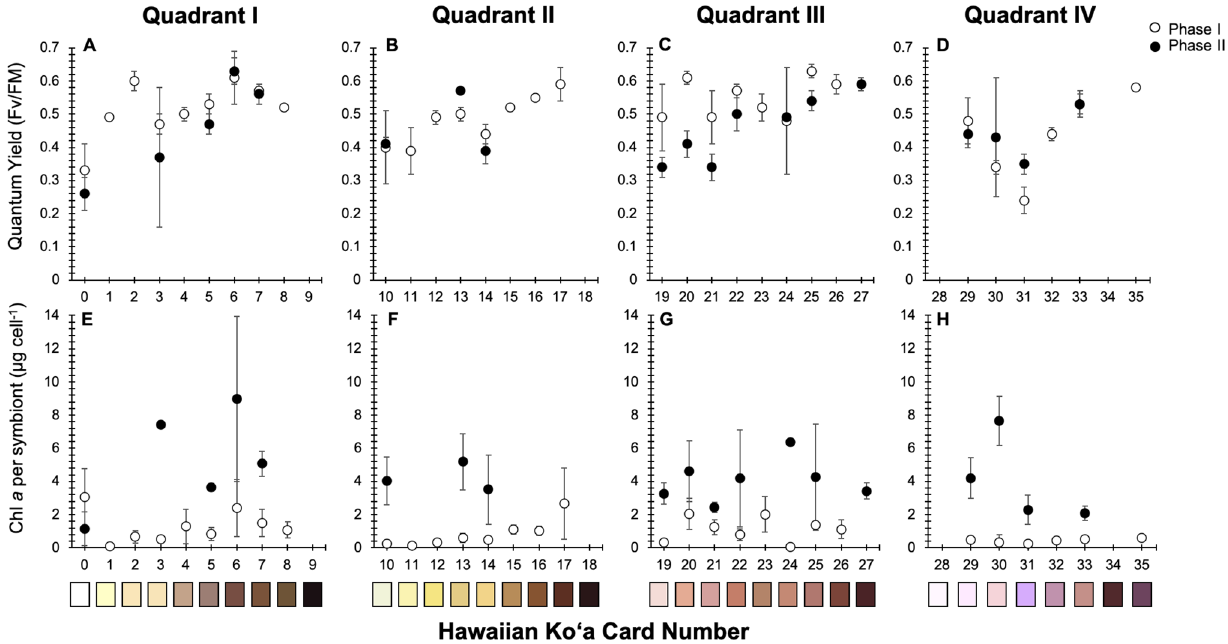
Fig. 7 Coral health parameters of quantum yield ( A – D ) and chlo- rophyll a per symbiont ( E – H ) for Phase I (white circle) and Phase II (black circle) data by Hawaiian Ko ʻ a Card number separated by